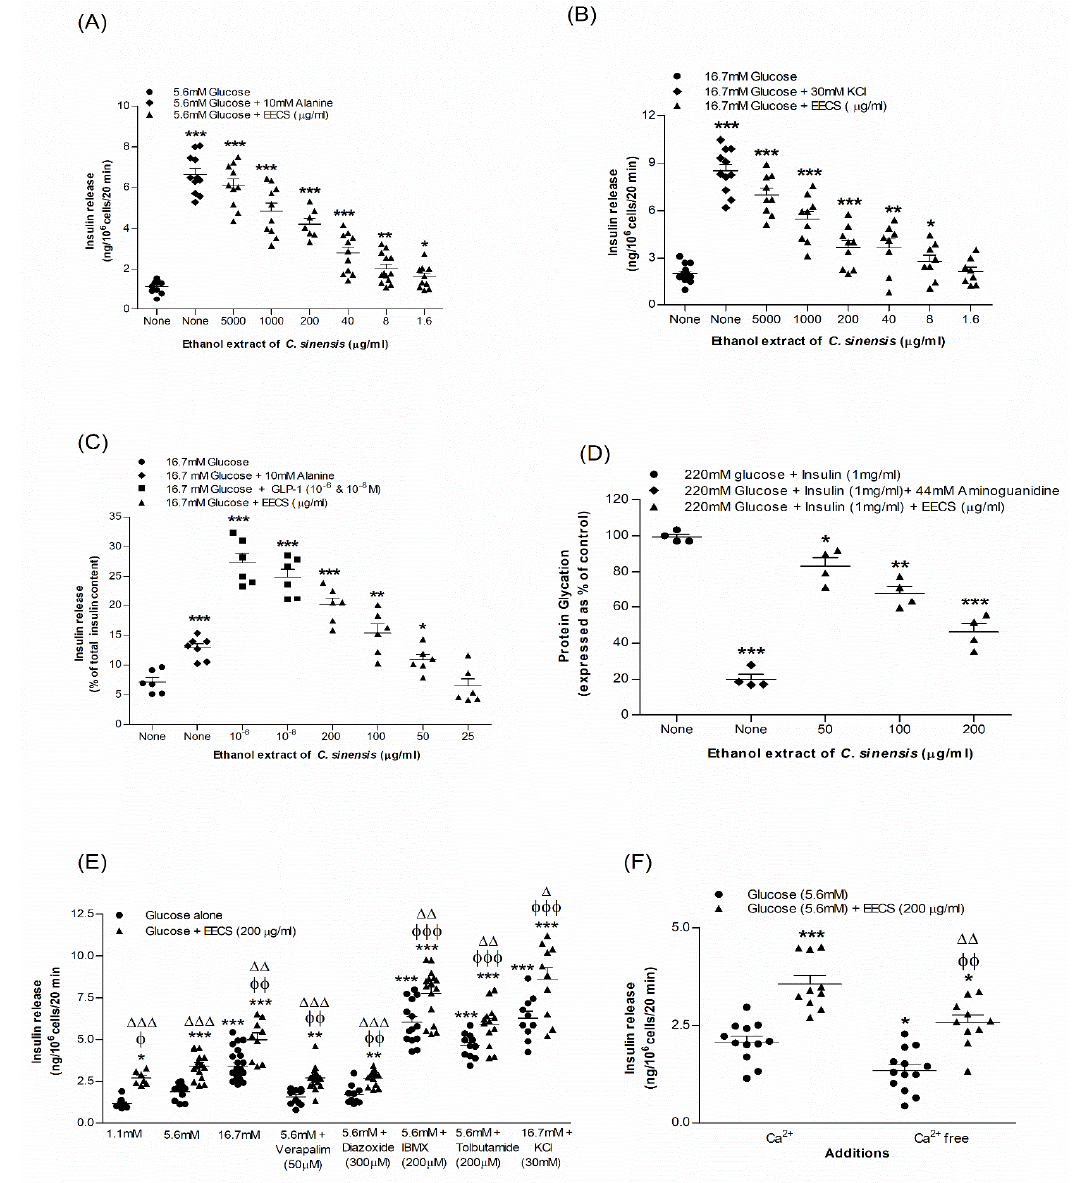
Figure 1. Effects of EECS on insulin secretion from ( A , B ) clonal pancreatic BRIN-BD11 β cells and ( C ) islets of Langerhans, ( D ) glycation of protein ( E ), secretion of insulin with known stimulators/inhibitors and ( F ) plus/minus extracellular calcium from BRIN-BD11 cells. Values n = 4–8 for insulin secretion and glycation of protein are mean ± SEM. * , ** , *** p < 0.05–0.001 compared to control. ϕ , ϕϕ , ϕϕϕ p < 0.05–0.001 compared to 5.6 mM glucose with EECS. Δ , ΔΔ , ΔΔΔ p < 0.05–0.001 compared to respective incubation without EECS. EECS, ethanol extract of C. sinensis.